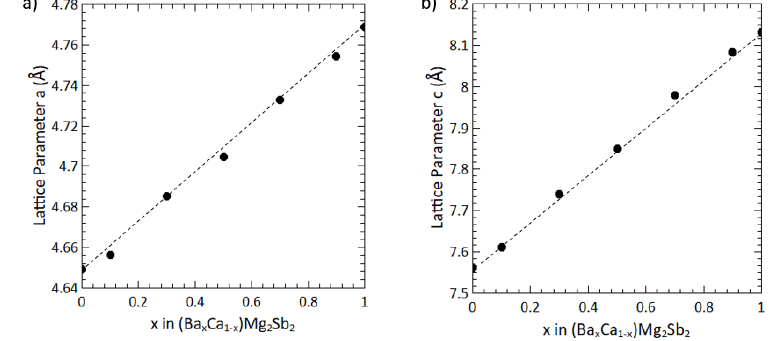
Figure 3. The linearly varying lattice parameters in the (Ba x Ca 1 − x )Mg 2 Sb 2 alloy indicate complete solid solubility of this system. ( a ) The lattice parameters a and ( b ) c of (Ba x Ca 1 − x )Mg 2 Sb 2 .